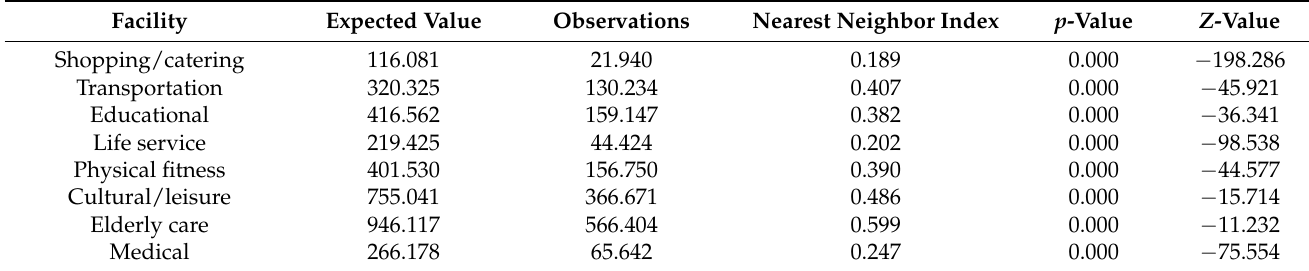
Table 2. Agglomeration index for public service facilities and housing